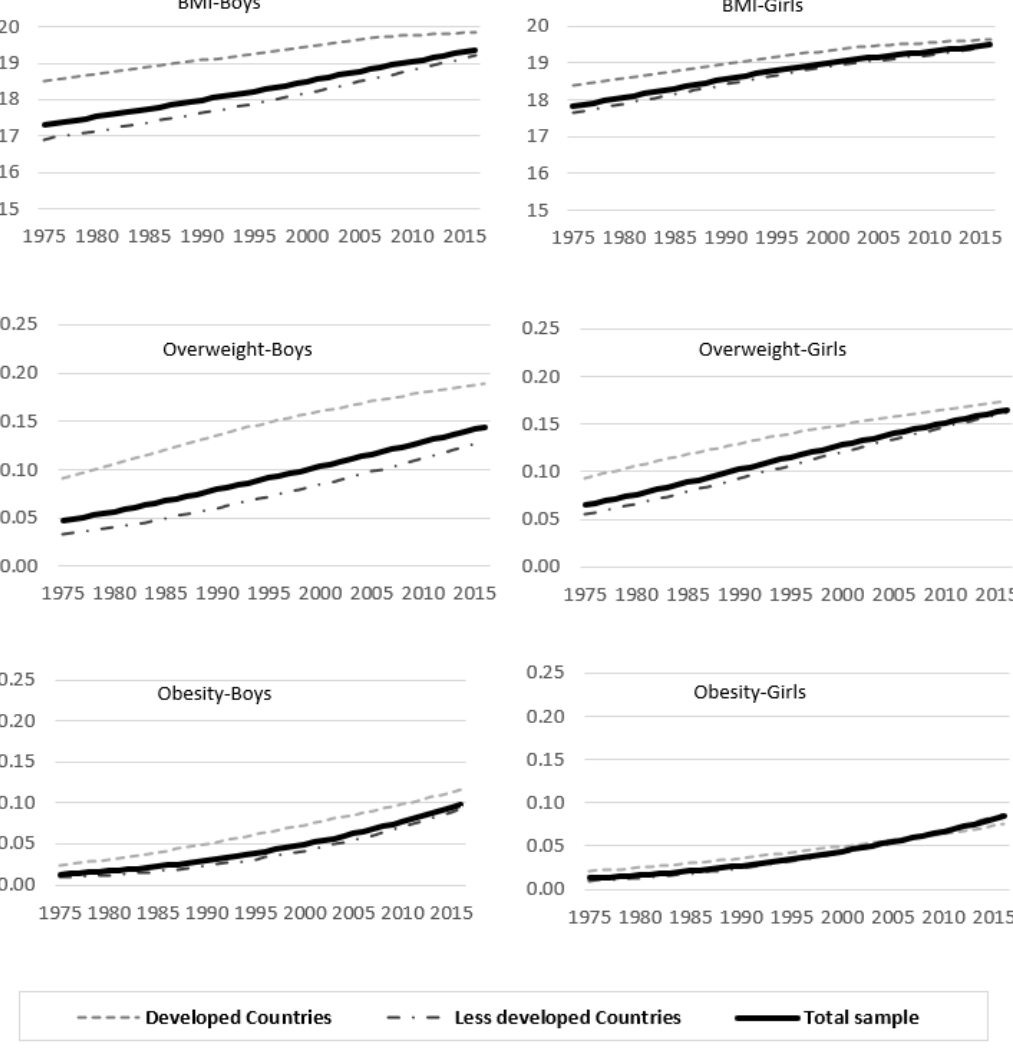
Table A1. Number of countries by Club and region.